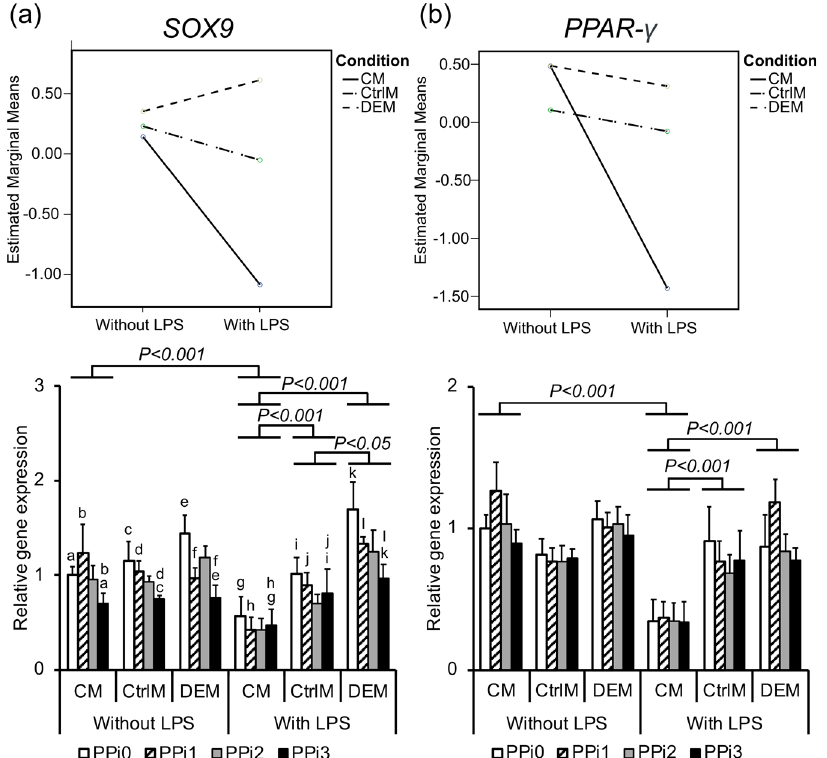
Fig. 6 Gene expression of chondrogenic and adipogenic factors in mesenchymal stem cells (MSCs). Gene expression analysis of ( a ) chondrogenic transcription factor SRY-box 9 ( SOX9 ) and ( b ) adipo- genic transcription factor peroxisome proliferator-activated receptor gamma ( PPAR- γ ) in MSCs after 72 h of culture in different culture media: CM = conditioned media from monocytes incubated for 48 h in polystyrene well-plates in the presence or absence of lipopoly- saccharide (LPS) and exposed to different pyrophosphate (PPi) con- centrations; CtrlM = control media incubated for 48 h in polystyrene well-plates in the presence or absence of LPS and exposed to different PPi concentrations; DEM = direct effect media incubated for 48 h in 50 mL tubes and used for direct exposure of MSCs to LPS and